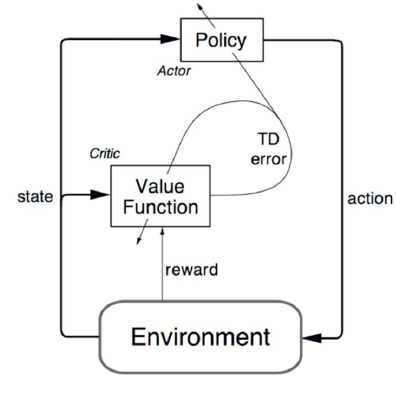
Figure 9. Actor–critic architecture. Algorithm 1. Pseudo-code of the Deep deterministic policy gradient (DDPG) algorithm.